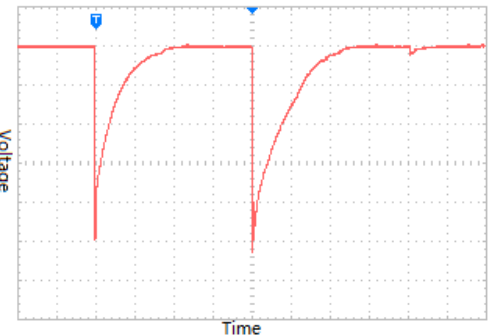
Figure 8. Three-pulse output abnormal waveform at 200 microseconds’ interval.